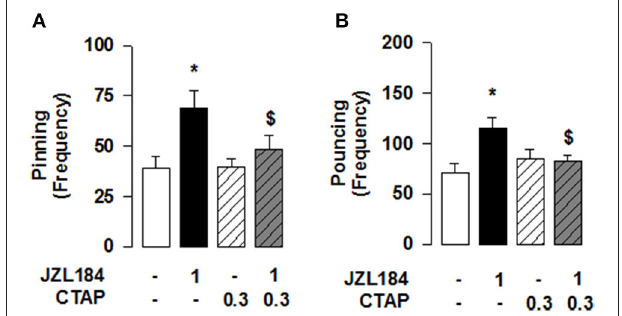
FIGURE 3 | 2-AG elevation stimulates social play via MOR in the NAcC in adolescent rats. Intra-NAcC infusion of the selective MOR antagonist CTAP (0.3 µ g/0.3 µ l) prevented the increase in pinning (A) and pouncing (B) induced by systemic treatment with JZL184 (1 mg/kg, i.p.). Data represent mean ± S.E.M. frequency of pinning and pouncing. * p < 0.05 vs. vehicle; $ p < 0.05 vs. vehicle/JZL184 (Student-Newman-Keuls post-hoc test). N = 7–9 per treatment